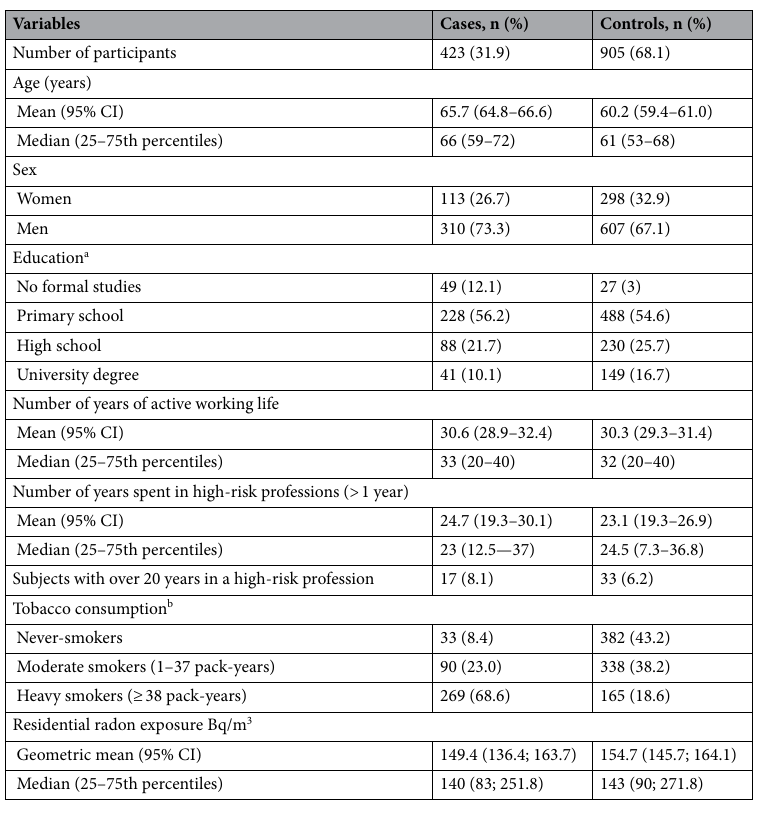
Table 1. Sample description broken down by case–control status. a Missing data for 17 cases and 11 controls. b Missing data for 31 cases and 130 controls.